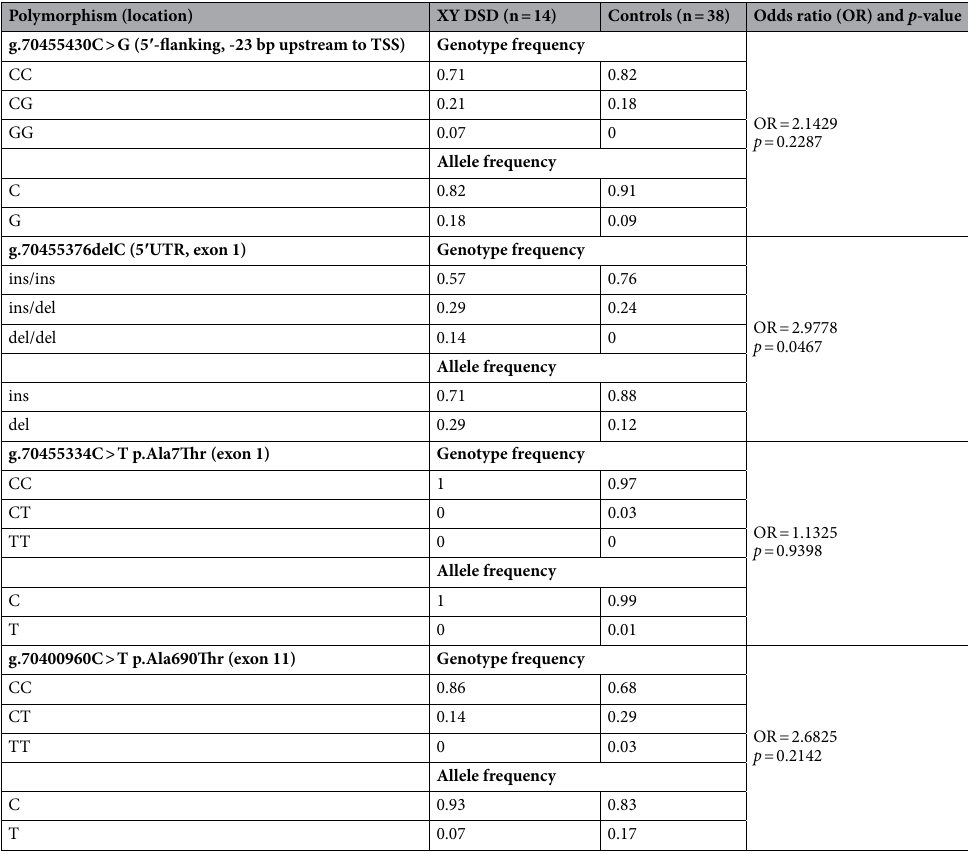
Table 4. Frequencies of genotypes and alleles for variants in the LHCGR gene analyzed in XY DSD cases versus control group.